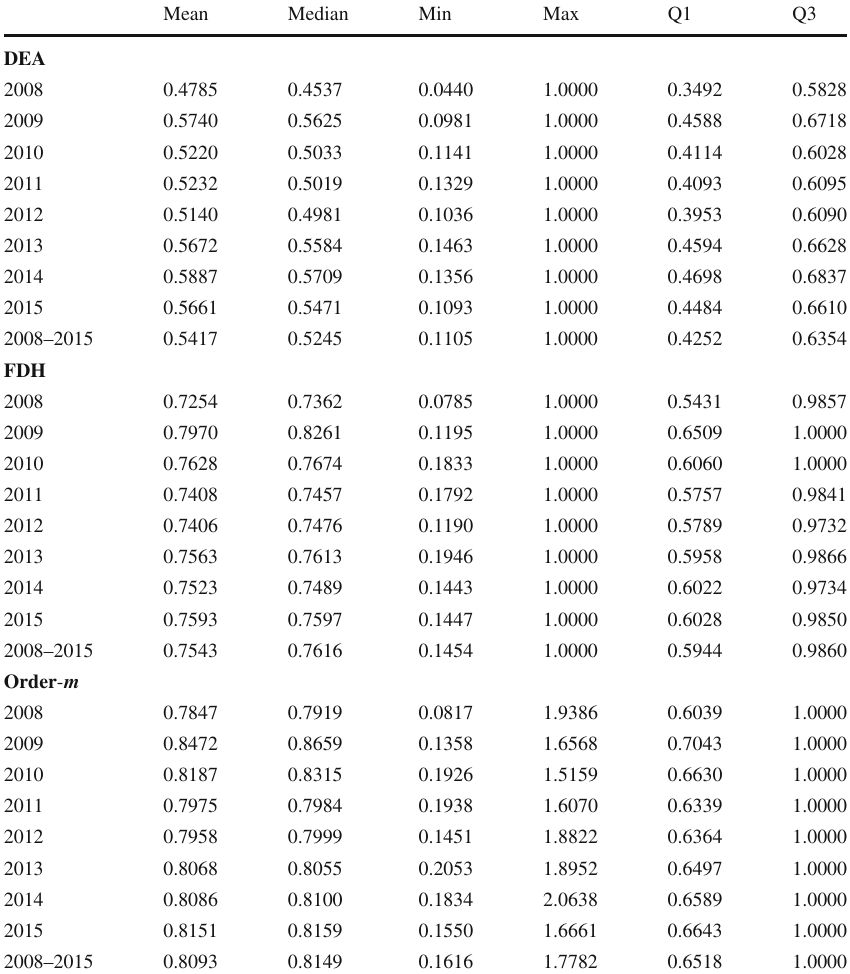
Table 7 Summary statistics for efficiency results in Spanish local